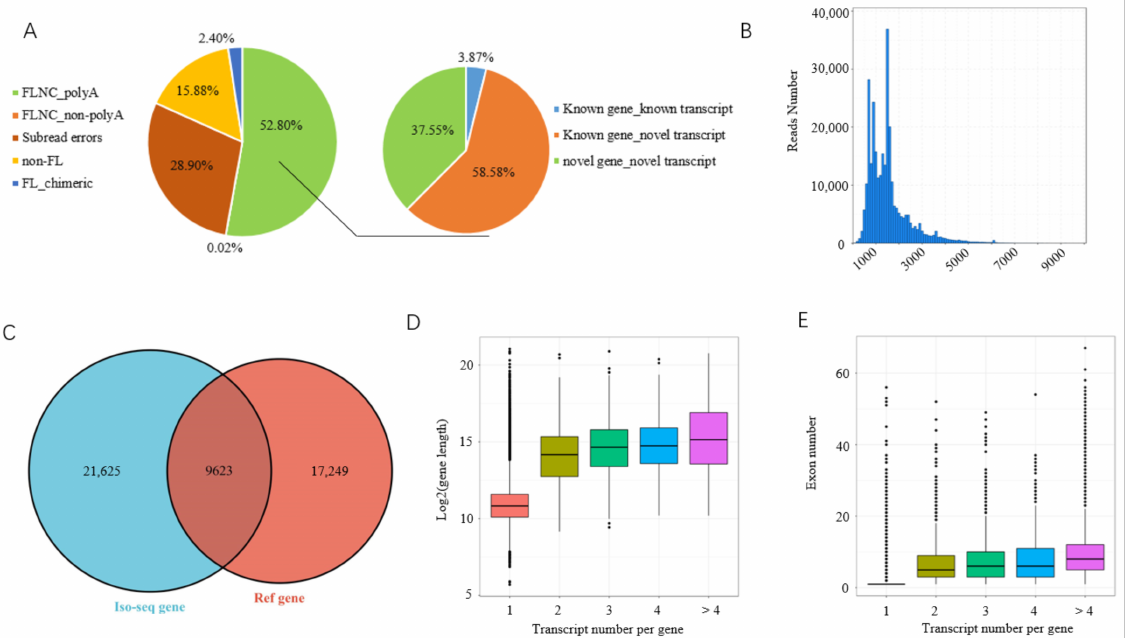
Figure 1. Analysis of Iso-seq data. ( A ) Classification of raw Iso-seq reads; ( B ) length distribution of full-length nonconcatemer reads; ( C ) Venn diagram depicting overlapped genes between Iso-seq and reference genome data; ( D ) analysis of gene length amongst genes generating different numbers of transcripts; ( E ) analysis of exon numbers among genes generating different numbers of